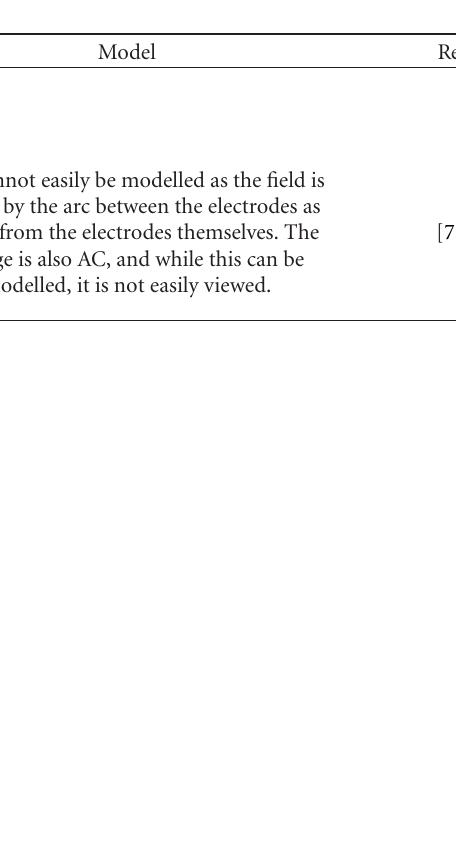
(Figure 5). All the results are plotted along a vertical line from the burner mouth to the upper electrode at 60 mm, along the axis of symmetry. Only number 6 cannot be plotted in this way as there is a wire acting as the ground electrode along the axis of symmetry. The most uniform fields should appear as a flat horizontal line of the highest possible field